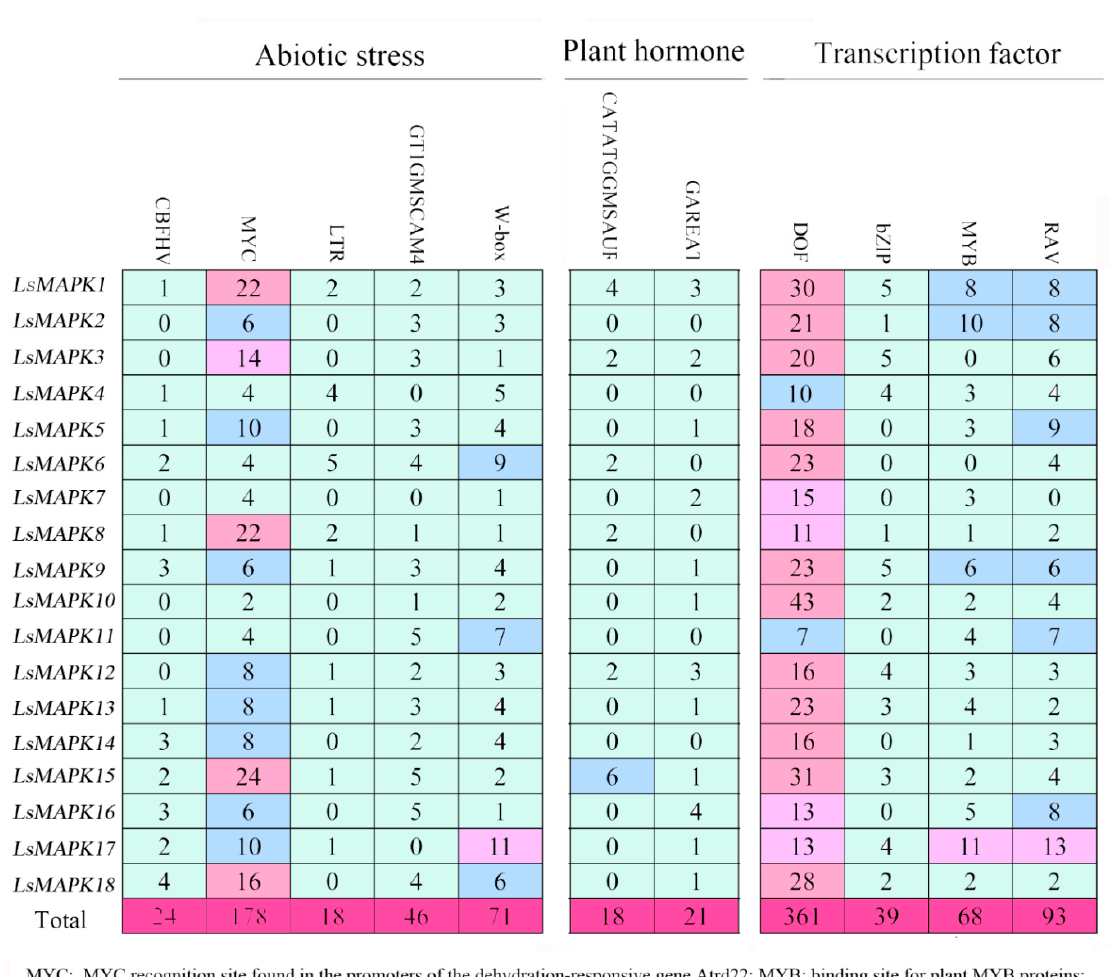
Figure 3. Cis -element analysis of LsMAPK genes in lettuce by PLACE database. Boxes with different numbers represent each cis -element identified by the PLACE database. Different colors represent different number ranges of identified cis